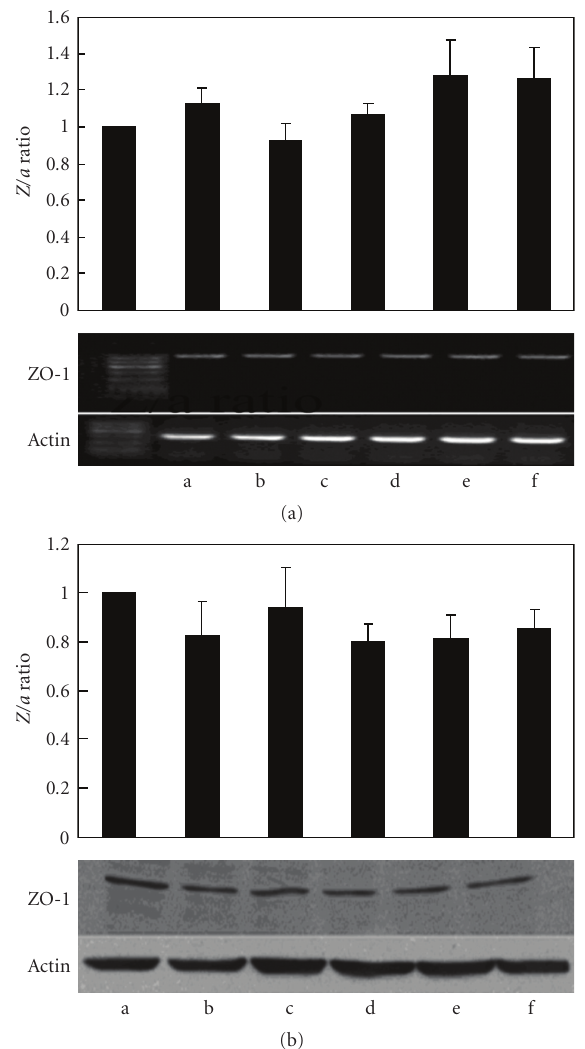
Figure 1: Hypercholesterolemic serum could not change ZO- 1 expression in mRNA (a) or protein (b) level. a: serum free medium; b: normal rabbit serum; c–f: hypercholesterolemic serum at di ff erent cholesterol concentrations. Z/a ratio was calculated as below: the ratio of ZO-1 to actin in control group was regarded as 1 in every test. And Z/a ratio in other groups was adjusted to control group.